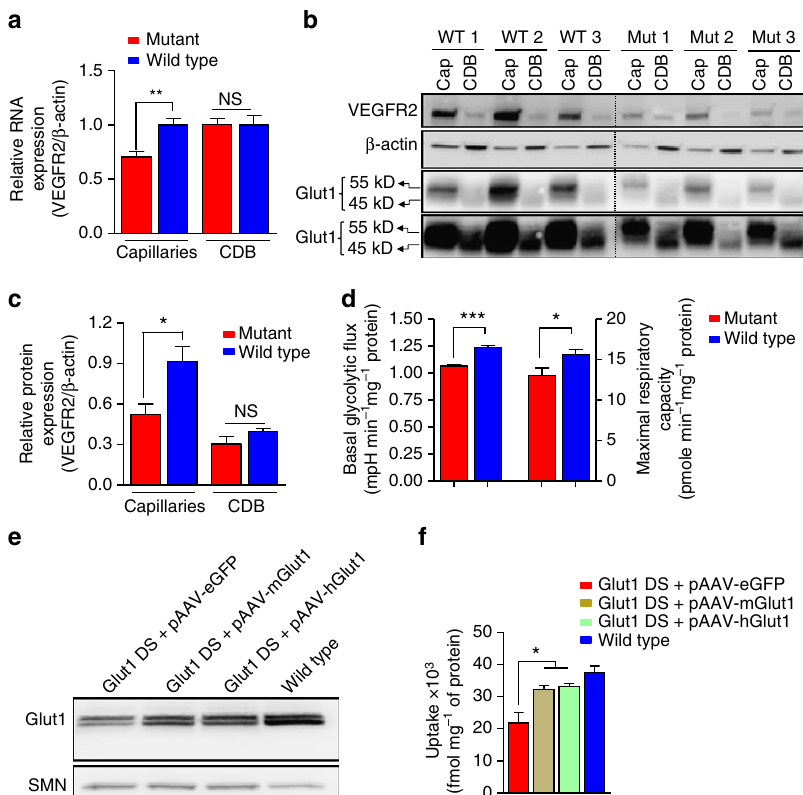
Figure 3 | Potential mediators of angiogenesis defects in Glut1 DS and a functional evaluation of Glut1 constructs for gene replacement. ( a ) A quantification of Vegfr2 RNA levels demonstrates reduced transcripts specifically in the capillaries of the Glut1 DS brain. ( b ) Western blot analysis and ( c ) a quantification of Vegfr2 protein in the capillaries (Cap) and the capillary-depleted brain (CDB) fraction also depict reduced protein in mutant brain vessels. Also shown in the blot are corresponding Glut1 levels which are particularly high in the capillaries (55kDa isoform) compared with the CDB fraction (45kDa isoform). Results of high as well as low exposure times are depicted. ( d ) Basal glycolytic flux and maximal respiration are both significantly compromised in cells from Glut1 DS model mice. Panels a–d: *, **, P o 0.05, P o 0.01, t -test, N Z 3 samples, 2 independent preparations. ( e ) Western blot depicting an increase in Glut1 protein following transfection of Glut1 DS patient fibroblasts with either a murine (lane 2) or human (lane 3) Glut1 cDNA construct. The ubiquitously expressed SMN protein was used as a loading control. ( f ) Quantitative representation of the levels of a radio- labelled glucose analogue, 2-DOG, taken up by cells transfected with the Glut1 constructs. Note the increase in the labelled 2-DOG in cells that were transfected with the Glut1 constructs. Also note, that pAAV denotes the fact that the relevant construct was a plasmid. *, P o 0.05, N Z 3 assays, one-way